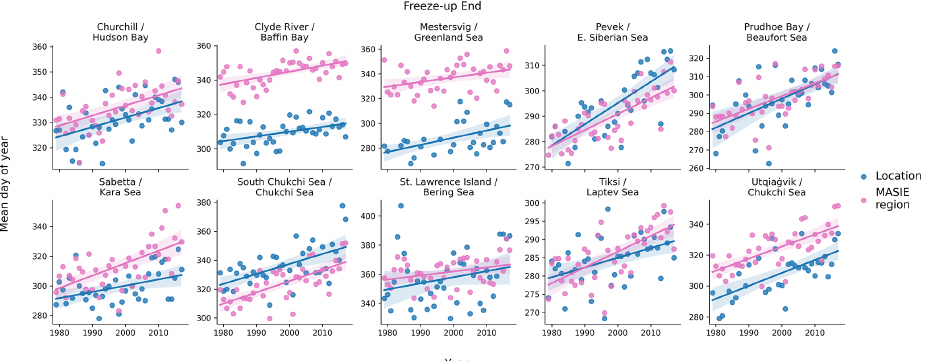
Figure 13. Yearly values (1979–2018) of the freeze-up dates (shown as day-of-the-year numbers) for the coastal locations (blue) and the corresponding MASIE regions (pink). Date scales on the y axis vary among panels in order to optimize the display of data points. Linear regression lines are shown with the same color coding. In each panel, the upper line of header identifies the coastal location and the lower line identifies the MASIE region. All values are based on the modified J&E algorithms. Slopes and their significance levels are listed in Tables S2 and